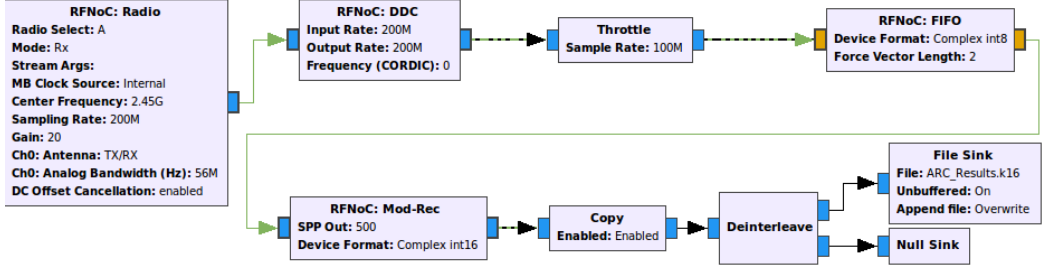
Figure 9. GRC flow diagram built using AMR blocks.